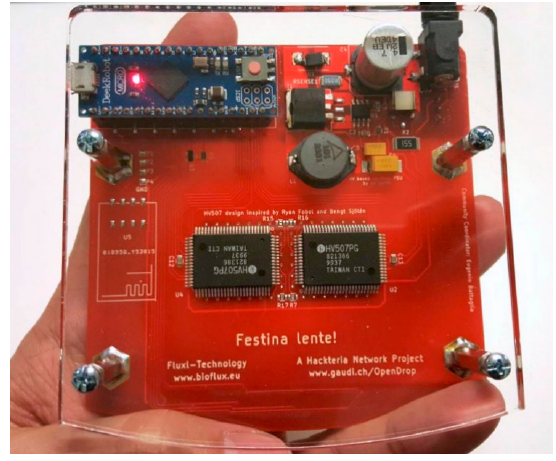
Figure 16. The back side of the next generation O PEN D ROP . We used a smaller Arduino and replaced the transistor array with two 64-Channel serial to parallel converters for high